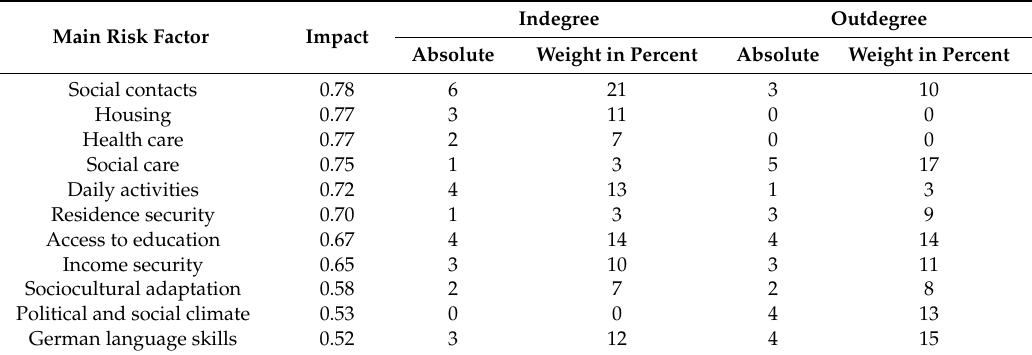
Table 3. Network metrics of the final system